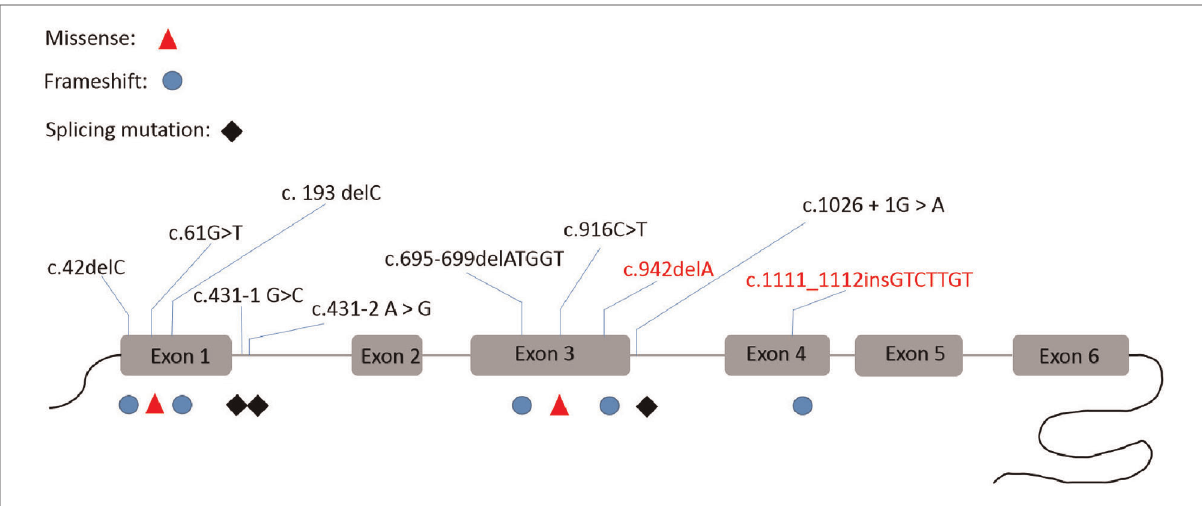
FIGURE 4 The SLC16A2 pathogenic variants that were reported in China. This is the fi rst report of c.942delA and c.1111_1112insGTCTTGT frame-shift variants in this